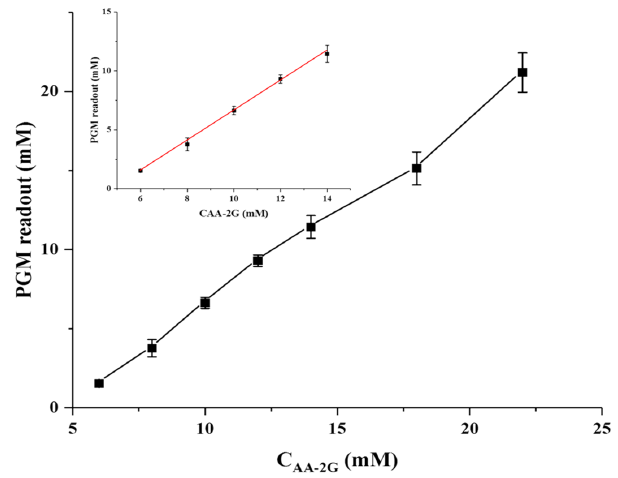
Figure 3. Effect of the concentration of AA-2G on the PGM readout. The inset is the linear relationship between the concentration of AA-2G and the PGM readout. Conditions: α-Glucosidase, 314.3 U/mL; incubation time, 15.0 min; AA-2G, 6.0–22.0 mM.